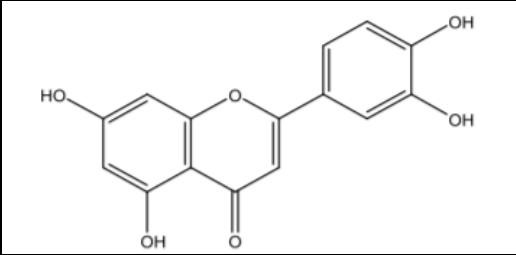
Figure 6. Chemical structure of luteolin (71)